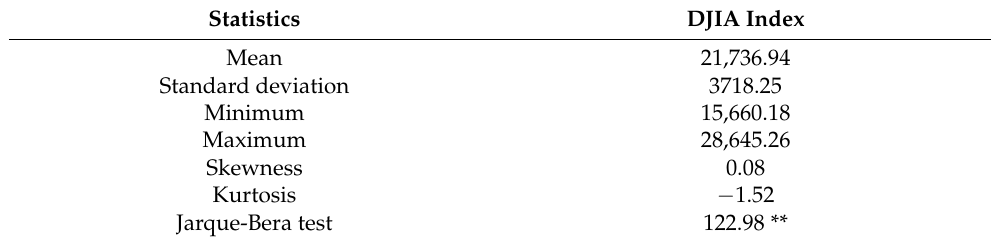
** indicates p -value lower than